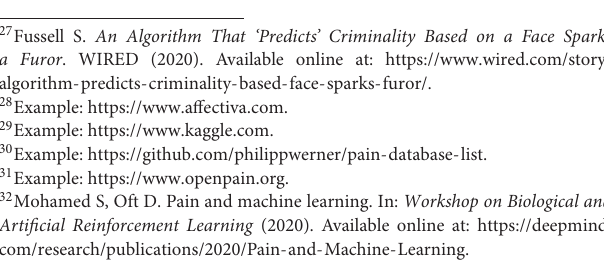
algorithm-predicts-criminality-based-face-sparks-furor/. 28 Example: